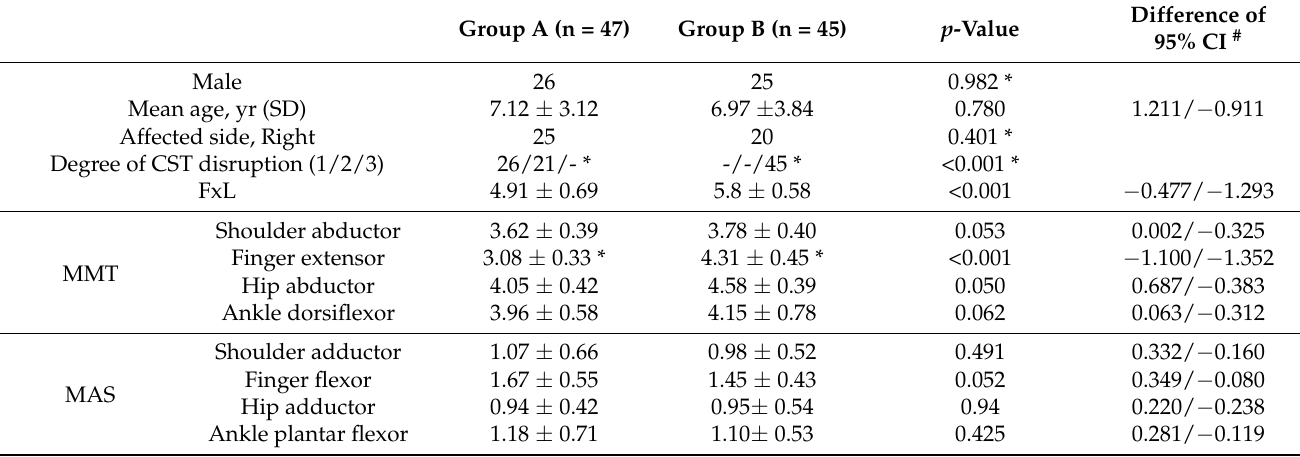
Table 1. Demographic and clinical data of the